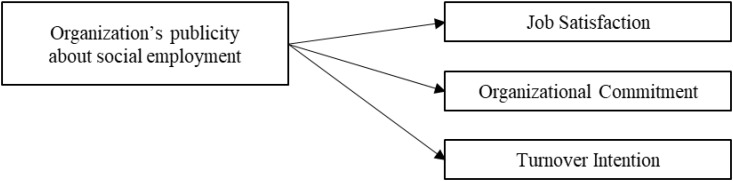
Research model 2.